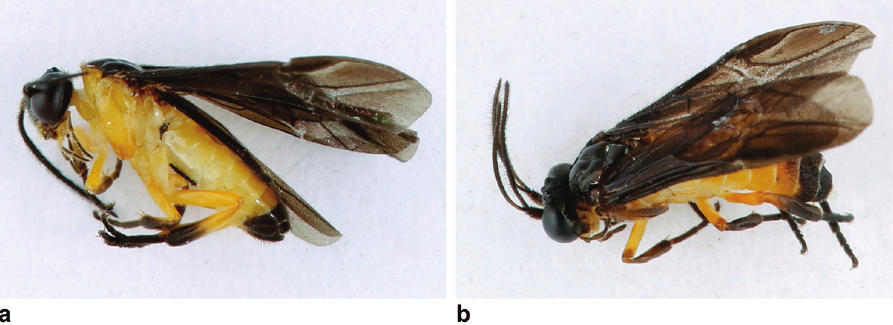
Figure 3. Manaos mulsus . a Female (P4214.G), body length 4.5 mm b male (P4221.D), body length 4.5 mm a Lateral view b dorso-lateral view.